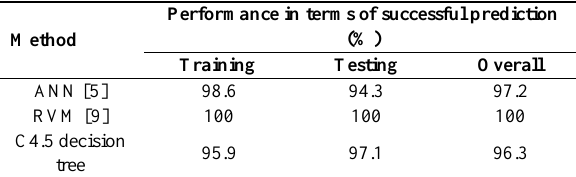
Table 4. Comparison of results of developed C4.5 decision tree with available ANN [5] and RVM models